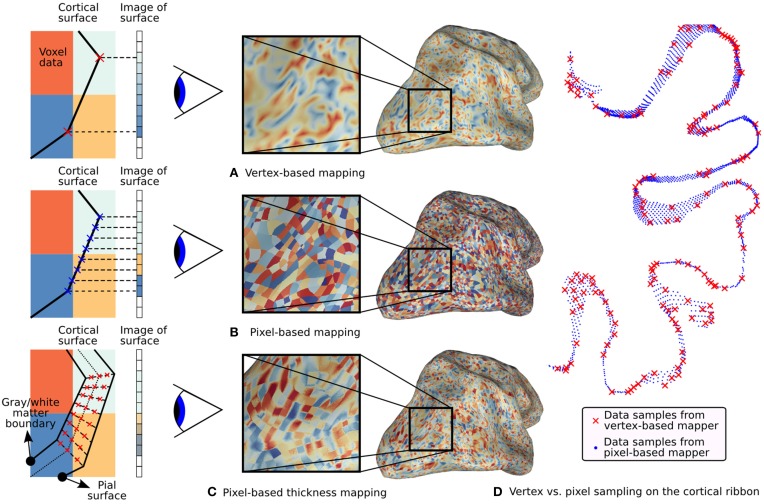
Typical fMRI data projections. On the left, simulated 2D volumes are projected onto a 1D screen. The large colored blocks represent voxel data and the small rectangles represent screen pixels. Three different mapping methods are illustrated along with their effect on the surface. (A) Standard vertex-based mapping uses vertices in the surface mesh to sample the underlying functional data. The vertices (red x's) sample the functional data using a nearest-neighbor algorithm and the values are automatically interpolated by the rasterizer. Although the surface passes through the orange voxel at bottom right, there are no orange pixels on the screen because there is no enclosed vertex. (B) Pixel-based mapping projects screen pixels into the volume to sample the underlying data. Orange pixels now appear on the screen since the surface passes through that voxel. (C) Thickness mapping samples data along the entire line between the white matter and the pial surface, thereby reflecting activity throughout the thickness of the cortical mantle. (D) The difference in sampling density between pixel-based and vertex-based mapping is shown for a 1mm slice through the cortical volume as it is mapped onto a flat map. Vertex samples are shown as red x's and pixel samples are shown as blue dots. The increased density improves the accuracy of functional data display, particularly with high-resolution functional data.